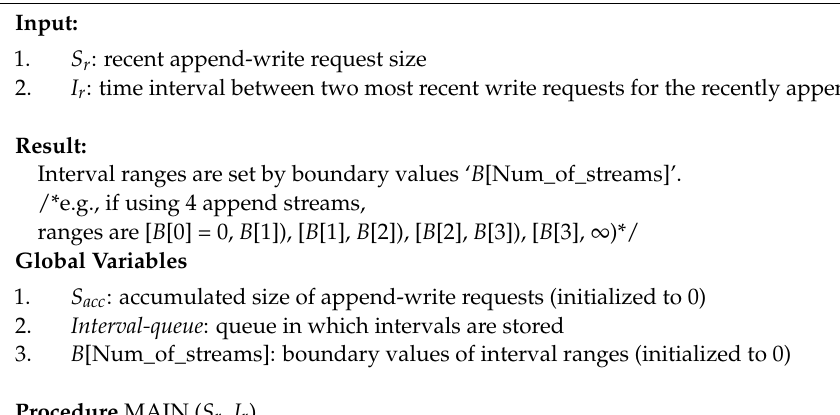
Algorithm A1. Interval range setting in append-write